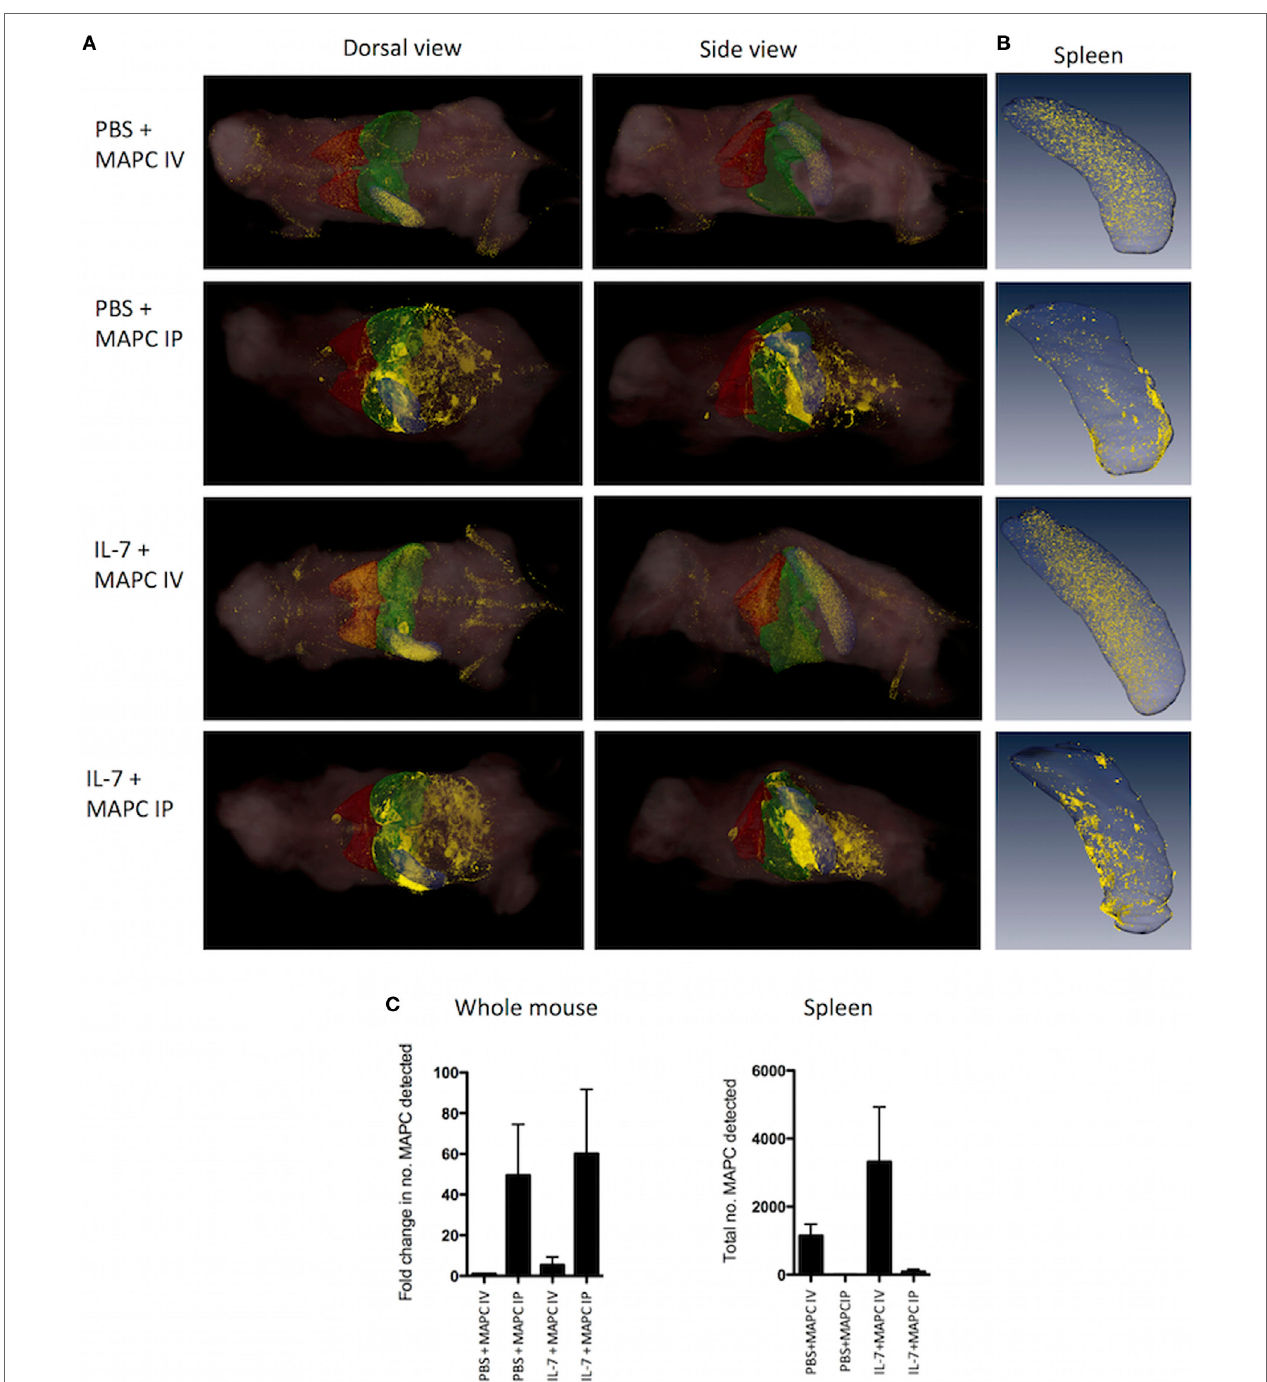
FigUre 5 | Multipotent adult progenitor cells (MAPC) administered intraperitoneally (IP) do not gain access to the spleen. 1 × 10 6 Qtracker ® 625-labeled MAPC were administered [intravenously (IV) or IP] to PBS and IL-7-treated mice and whole mice ( n = 3 per group) or spleen ( n = 3 per group) were harvested 48 h later. (a) CryoViz Images (left: dorsal view, right: side view. The lungs are depicted in red, liver in green, and spleen in blue). The majority of cells administered IV were detected in the lung, liver, and spleen, while MAPC administered IP were found in the peritoneal area surrounding abdominal organs. Representative images present 3D analysis of MAPC-treated mice with detected MAPC shown in yellow. (B) CryoViz Images of the spleen. MAPC IV were detected in the spleen; however, MAPC IP did not gain access to the spleen, but were detected in the omental tissue surrounding the spleen ( n = 3). 3D images show representative spleens with detected MAPC shown in yellow. (c) The fold change in the number of MAPC detected in whole mice and the total number of MAPC detected in spleens of mice at 48 h was quantified using quantification software ( n = 3). For the fold change calculation, the number of MAPC detected in the PBS + MAPC IV group was set to 1, and the fold change in the number of MAPC detected in the other groups was calculated based on this.